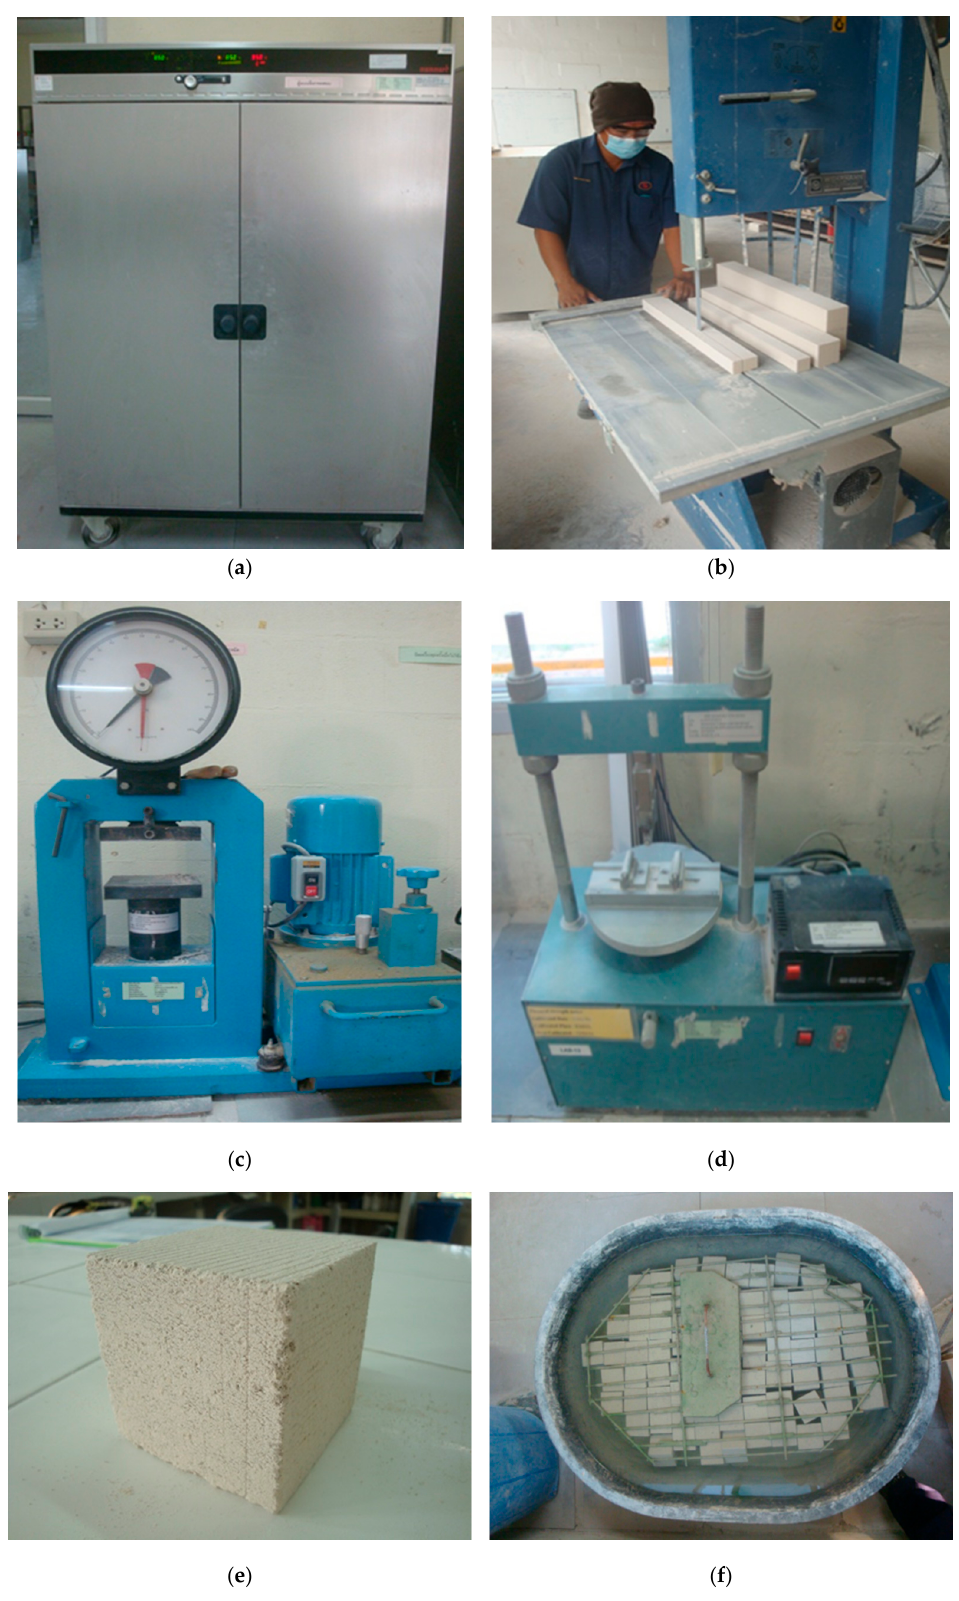
Figure 2. Hot air oven ( a ), cutting the AAC for the mechanical and physical test ( b ), compressive strength testing machine ( c ), flexural strength testing machine ( d ), size of concrete for compressive strength testing ( e ), concrete for absorption testing ( f